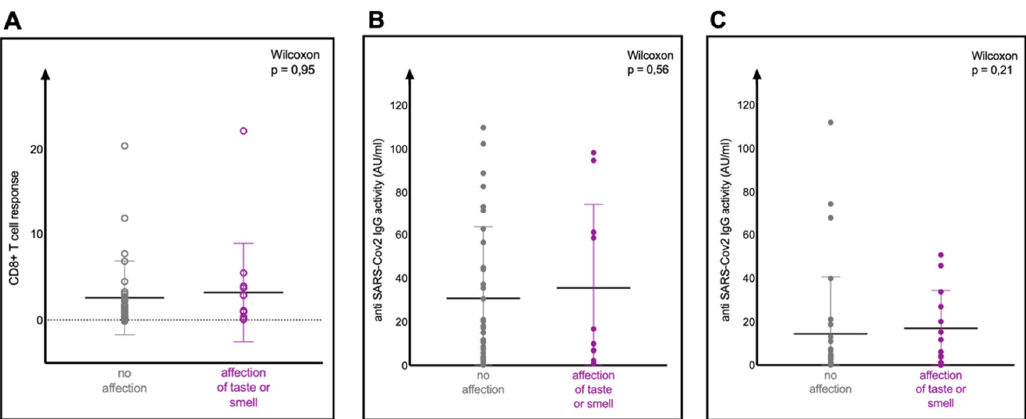
Figure A1. ( A ) CD8+ T-cell response (mean 63 days after positive RT-PCR test) of the participants with or without alteration of taste and smell ongoing after a median of 244 days after positive RT-PCR test. ( B , C ) Anti SARS-Cov2 IgG levels of the participants with or without alteration of taste and smell ongoing at 100 days (A1B) and 244 days (A1C) after positive RT-PCR test. Data analysis with the Wilcoxon test showed no significant difference between both groups.